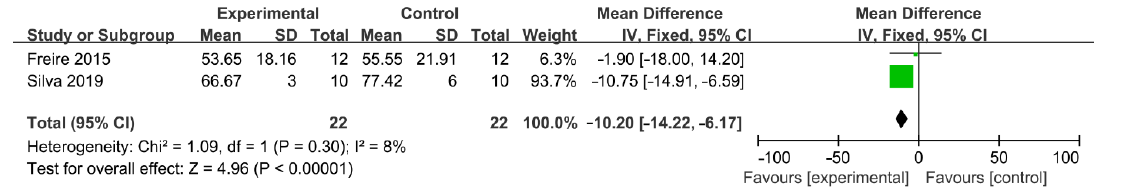
Figure 5. Forest plot and meta-analysis of comparison between negative pressure irrigation system and PUI [29,38].